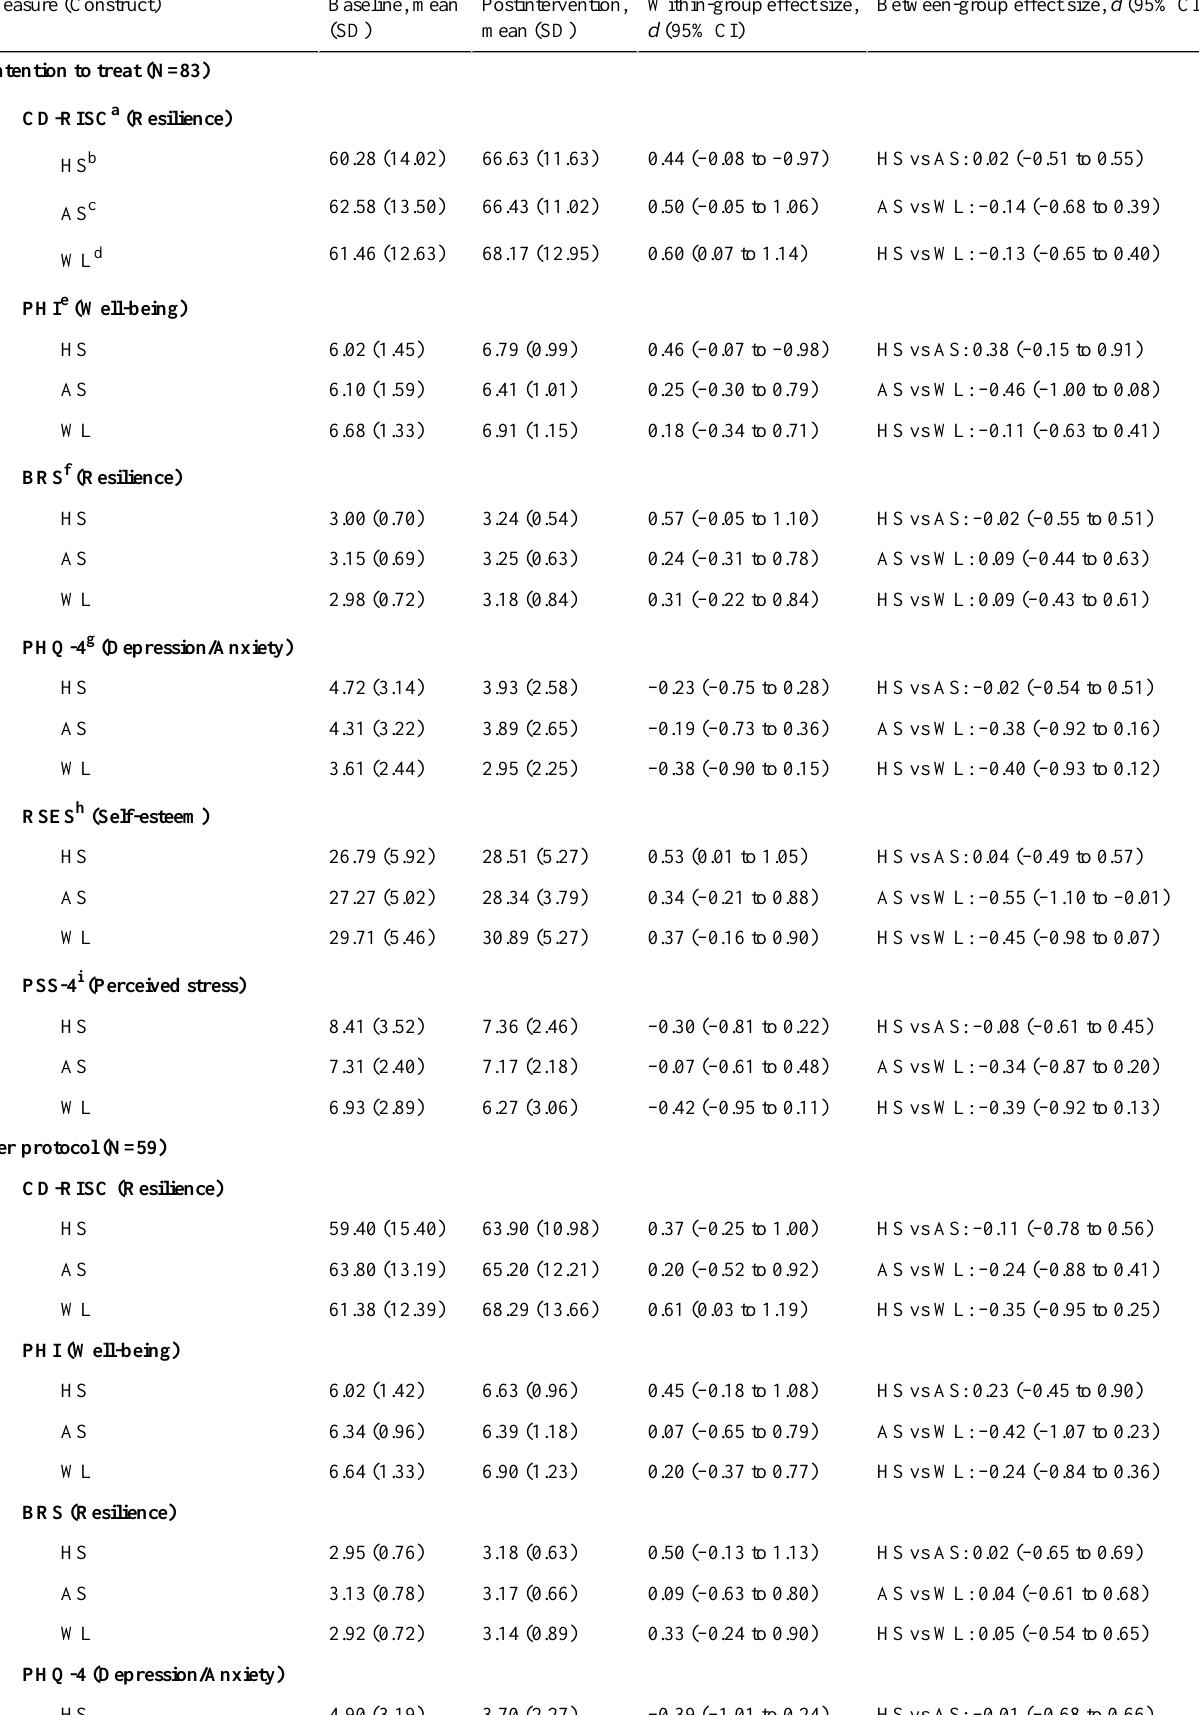
Between-group effect size, d (95% CI)Within-group effect